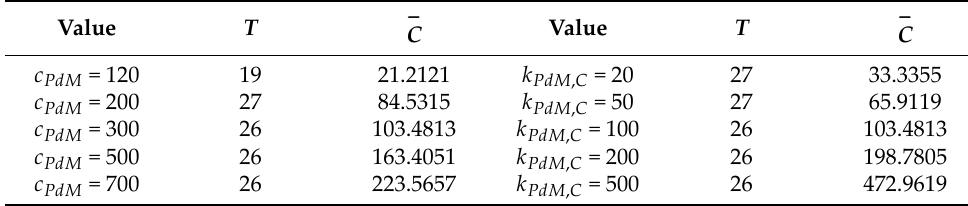
Table 6. Optimal results for different values of c PdM and k PdM , C .